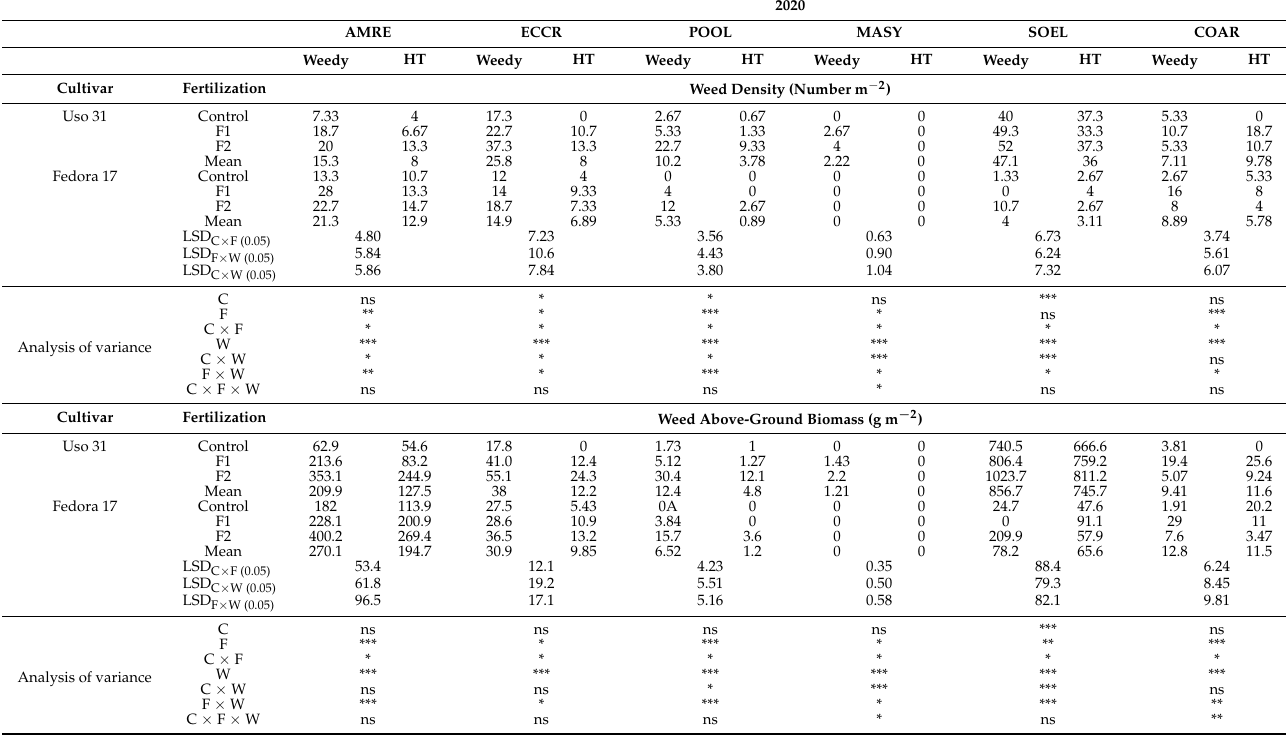
Table 4. The effects of the experimental factors on the average values and the analysis of weed density and weed above-ground dry biomass of weedy plots in the 2020 growing season. AMRE, A. retroflexus , ECCR, E. crus-galli , POOL, P. oleracea , MASY, M. sylvestris , SOEL, S. elaeagnifolium , COAR, C. arvensis . WM: weed management treatments (WF: weed-free; W: weedy; HT: herbicide-treated); C: cultivars; F: fertilization treatments (Control: without fertilization; F1: 70 kg ha − 1 ; F2: 140 kg ha − 1